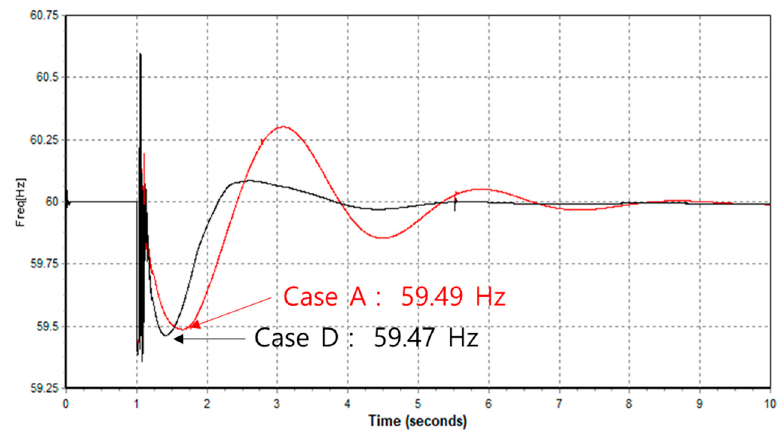
Figure 7. Simulation results of Cases A and D; effect of BESS operation.